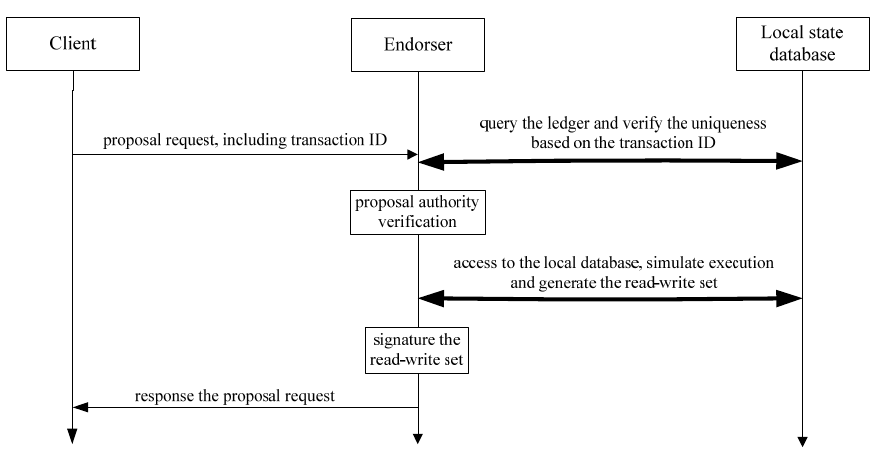
Figure 2. Original endorsement processing flow of Fabric.